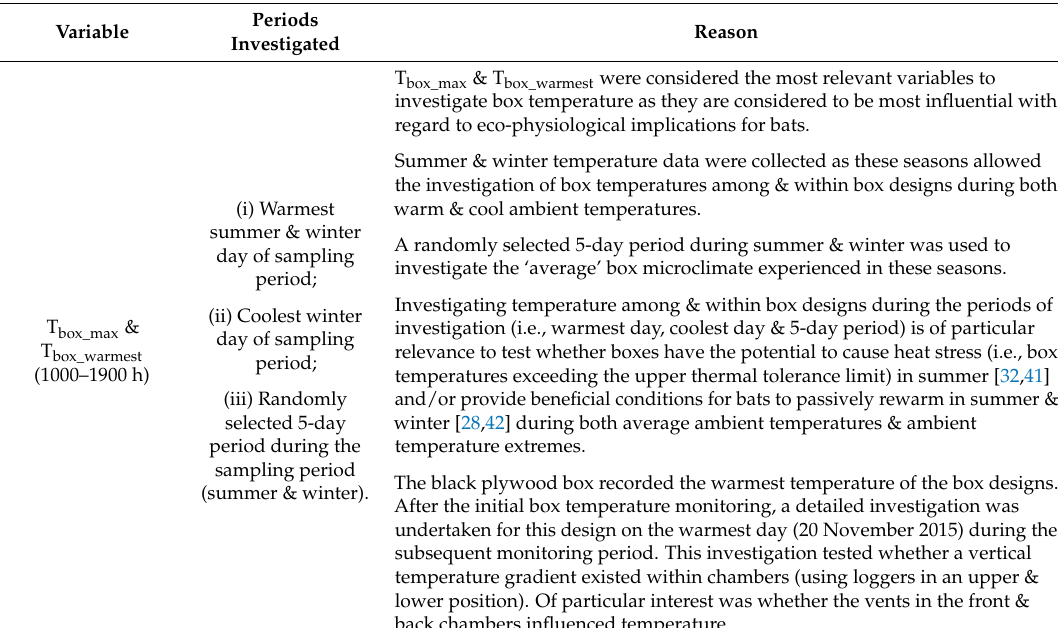
Table 1. Details and justification of the type of microclimate variables analysed. All four chambers within a box were analysed, except for T box_night and RH where only the front chambers were monitored. RH data were arcsine transformed for statistical analyses. Replication per chamber was four except for winter RH where chamber replication in black boxes was six. Statistical comparisons of chamber temperatures among box designs were restricted between chambers of the same order. For the randomly selected 5-day periods, the variable means over five days were used for the